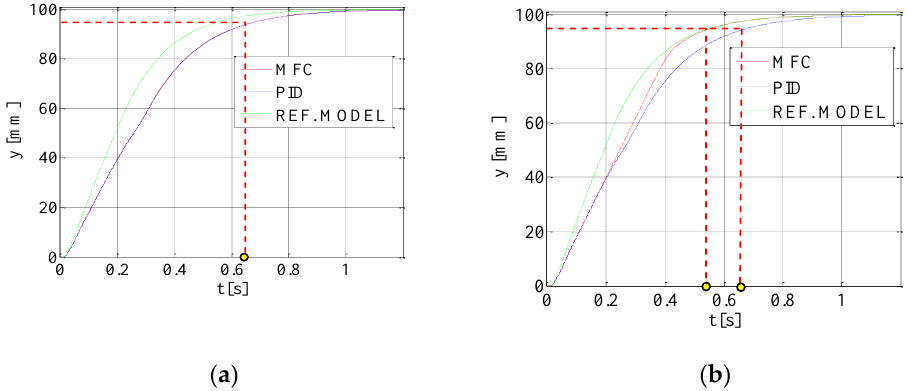
Figure 8. Impact of gain controller parameters for both loops (a) k ko = 1, ( b ) k ko = 4; p 0 = 12 MPa. The proposed controller, based on the MFC method, allowed a change to the flow coefficient K Q in the reference model, multiplying it by k q_k coefficient (Figure 1):